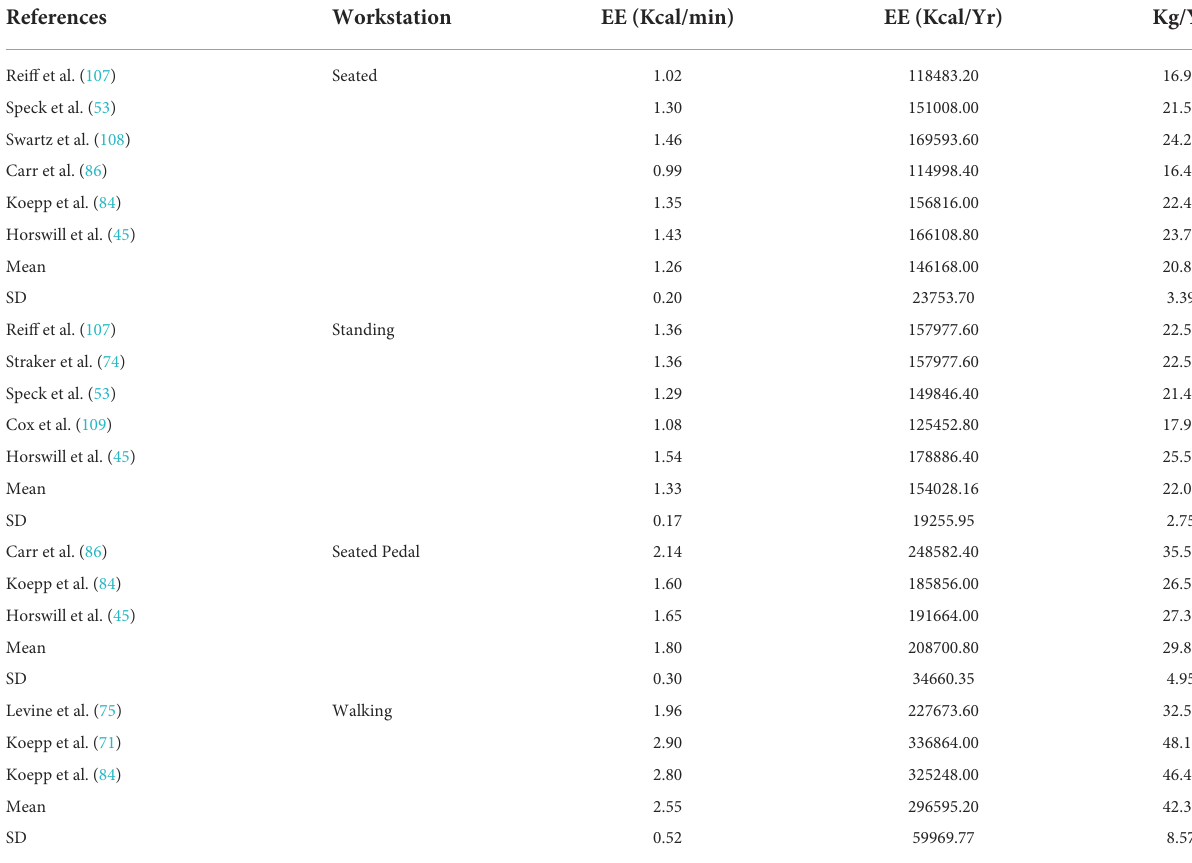
TABLE 1 Summary of energy expenditure (kcal/min and Kcal/yr) derived from the employment of alternative workstations (i.e., seated, standing, seated pedal, and